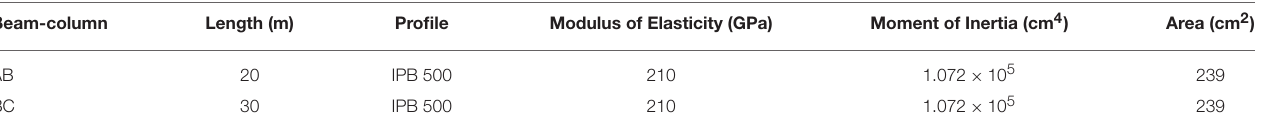
TABLE 2 | Properties of the structural members in Figure 4A